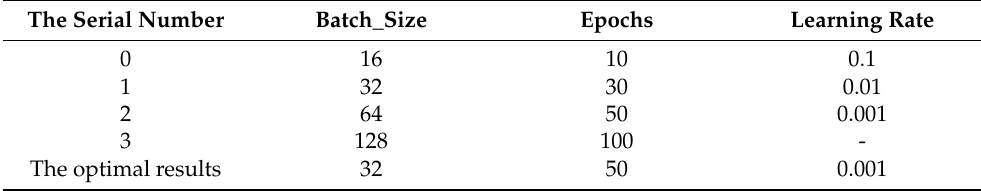
Table 2. The experimental setup and results.